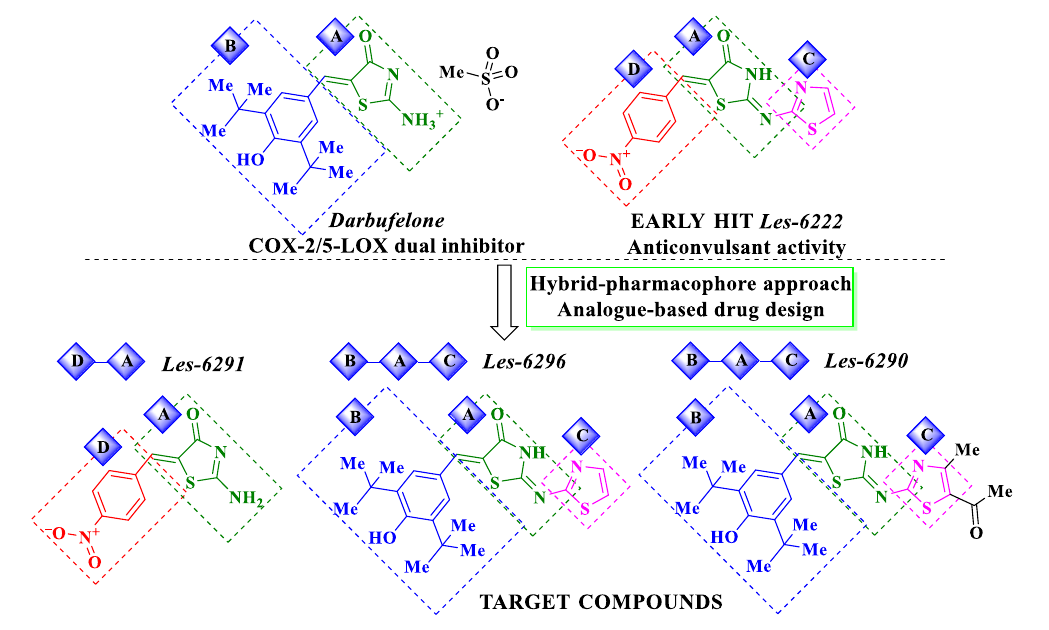
Figure 2. Background and design for the current work.